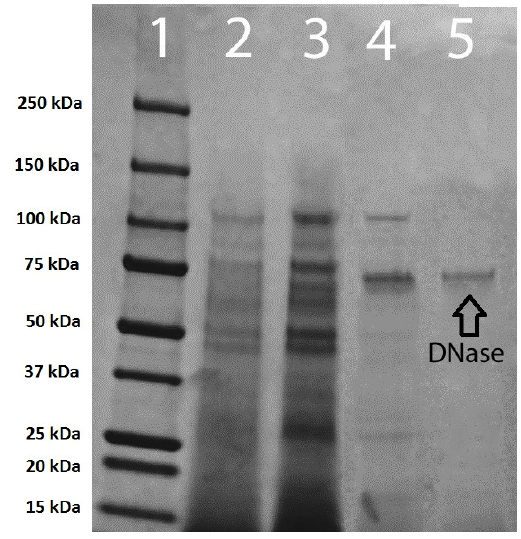
(Table 1). Polyacrylamide gel electrophoresis of pooled membrane purification samples concentrated from 40 to 15 mL indicated the presence of only one protein band (Figure 7). Figure 7. Electrophoresis of the various stages of DNase purification on a 4%–15% gradient polyacrylamide gel. ( 1 ) 250–10 kDa protein ladder; ( 2 ) crude